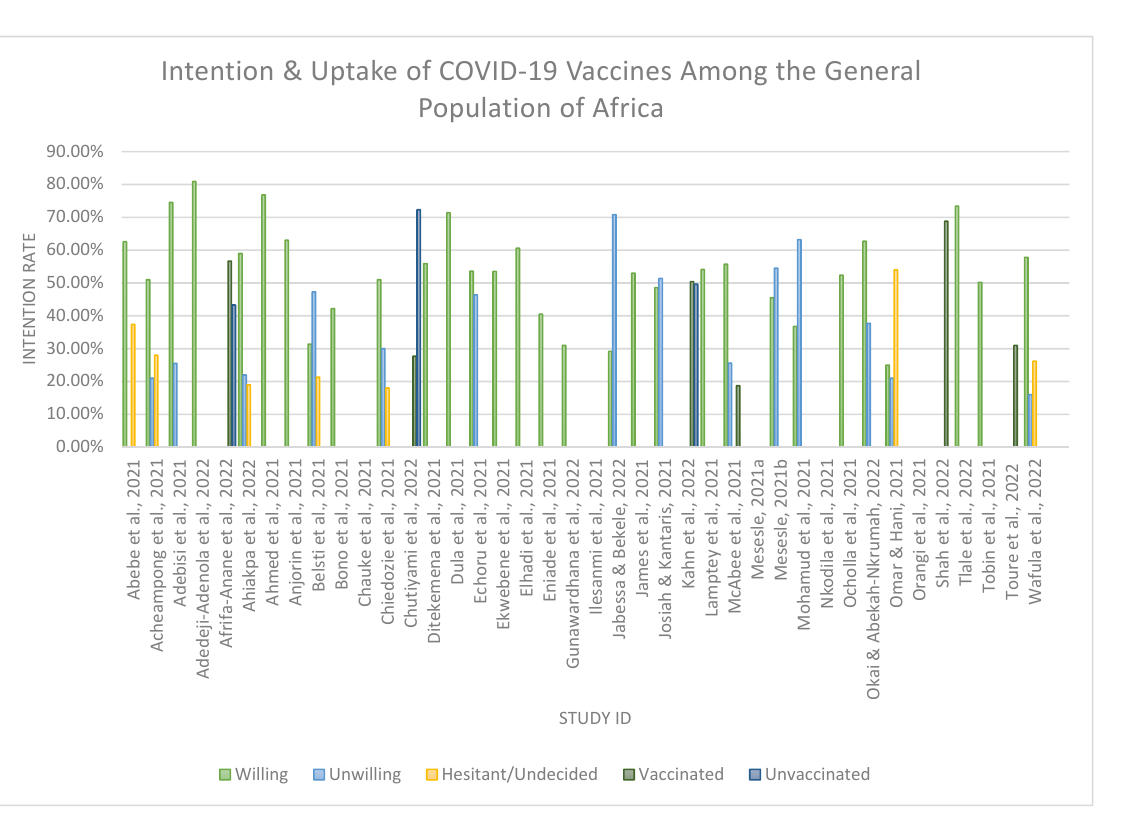
Figure 2. An illustration of COVID-19 vaccine uptake rates among the included studies in Africa. [25–37,39–45,47–52,54,55,57–59,61–64] Jabessa and Bekele [47] reported the highest rejection rate (70.8% in Ethiopia). Omar and Hani [59] reported the highest VH rate (54% in Egypt) for uptake of the COVID-19 vaccine. The subsequent studies reported that participants had been vaccinated against COVID-19 [30,35,40,50,52,61]. Of those three studies [35,50,61], it was indicated that above